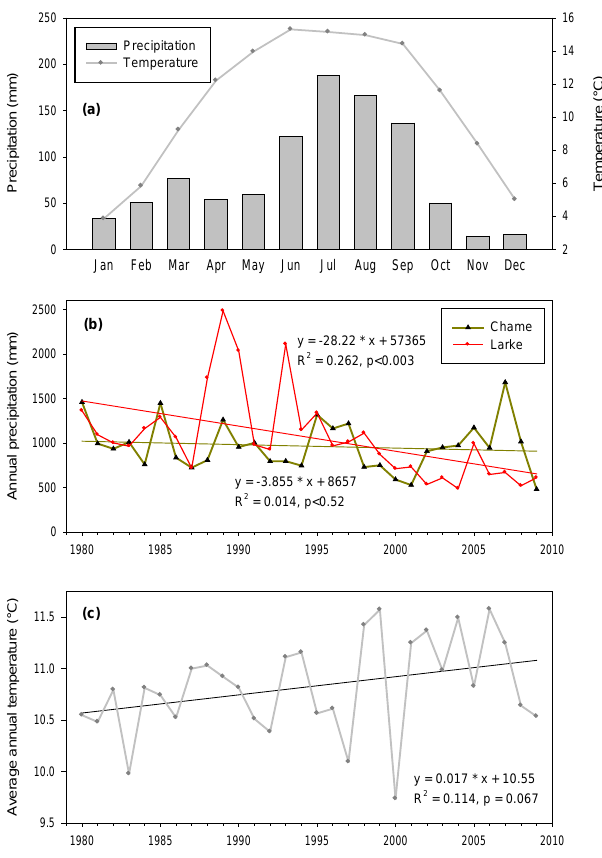
Figure 1. Climatic trend in the local stations: mean monthly (1980– 2009) precipitation and temperature at Chame, Manang station (a) ; annual trend of precipitation at Larke, Gorkha and Chame (b) , and trend of mean annual temperature at Chame (c)